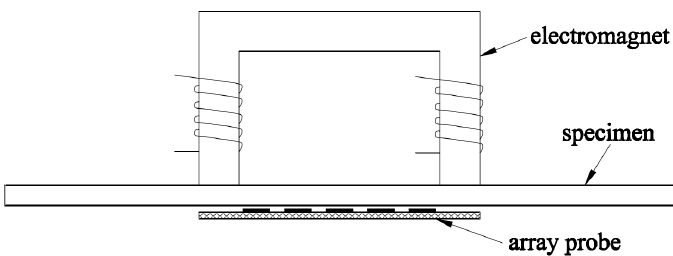
Figure 4. Sketch of the measurement method.